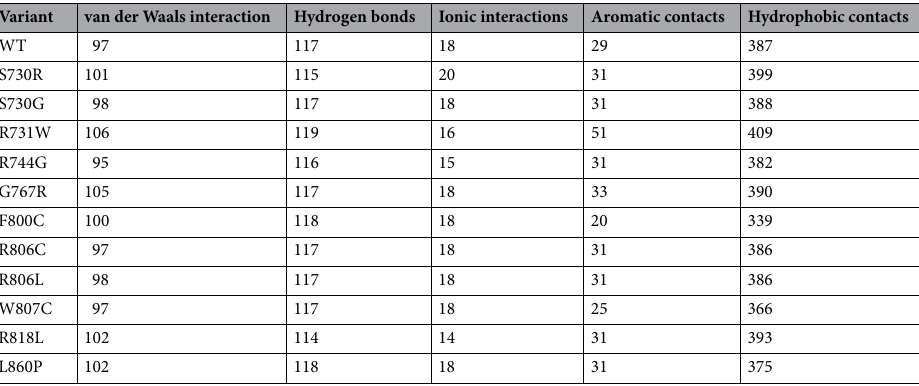
Table 2. Calculation of non-covalent interatomic interactions of wild-type and mutant CTC1 structures using the Arpeggio server.